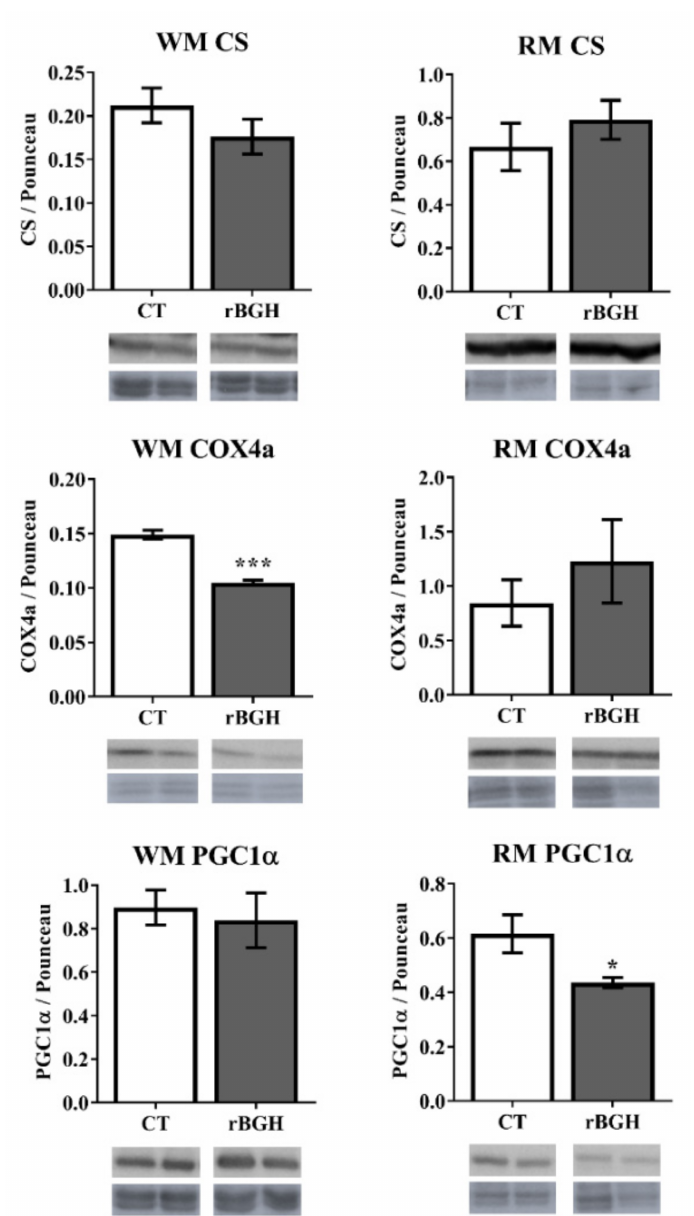
Figure 2. Protein expression of citrate synthase (CS), cytochrome-c-oxidase (COX4a) and peroxisome proliferator-activated receptor gamma coactivator 1-alpha (PGC1 α ) in white and red muscle after 9 weeks of rBGH injection on gilthead sea bream juveniles. Specific immunoreactive bands were normalized to total protein staining with Ponceau S and shown as means ± SEM ( n = 6). Intermem- brane variability was normalized using a random sample as a protein load control (more details in Supplementary materials: Figure S2). Significant differences between control and rBGH groups for each protein were determined by Student’s t -test and are marked with (*) p < 0.05; (***) p < 0.001. Abbreviations: WM (white muscle) and RM (red